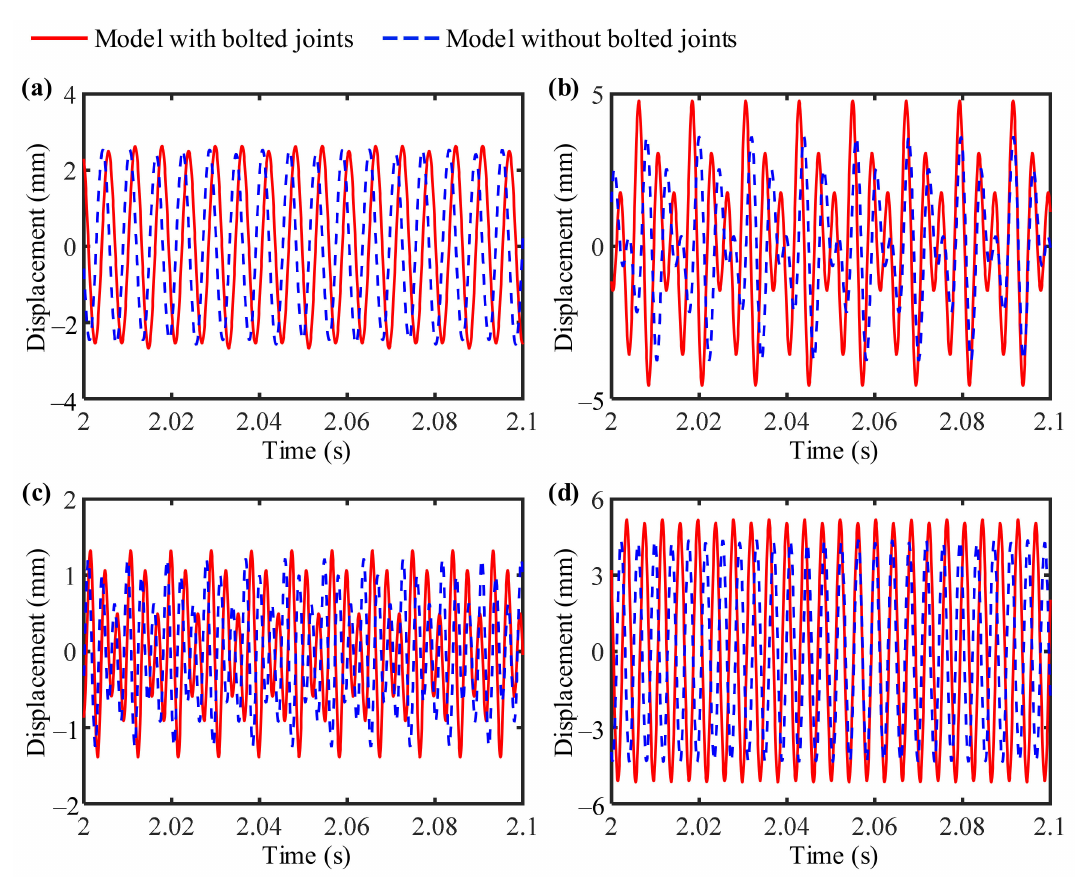
Figure 7. Time responses between the models with and without bolted joints: ( a ) 6567 and 6591 rpm; ( b ) 9845 and 10,051 rpm; ( c ) 13,074 and 13,377 rpm; ( d ) 14,802 and 15,531